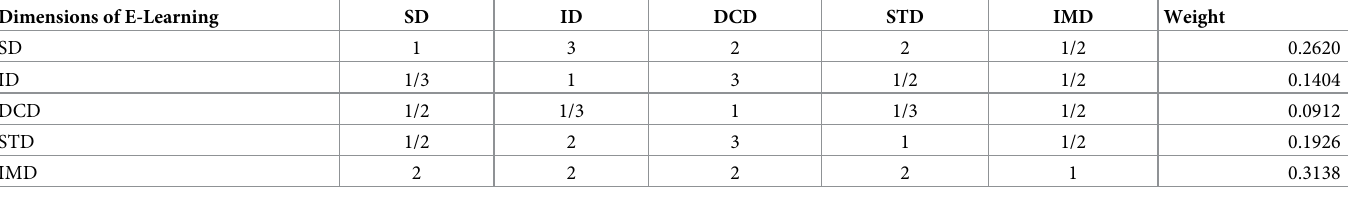
Table 4. A pairwise comparison of E-Learning dimensions by DM2 using AHP-GDM. Dimensions of E-Learning